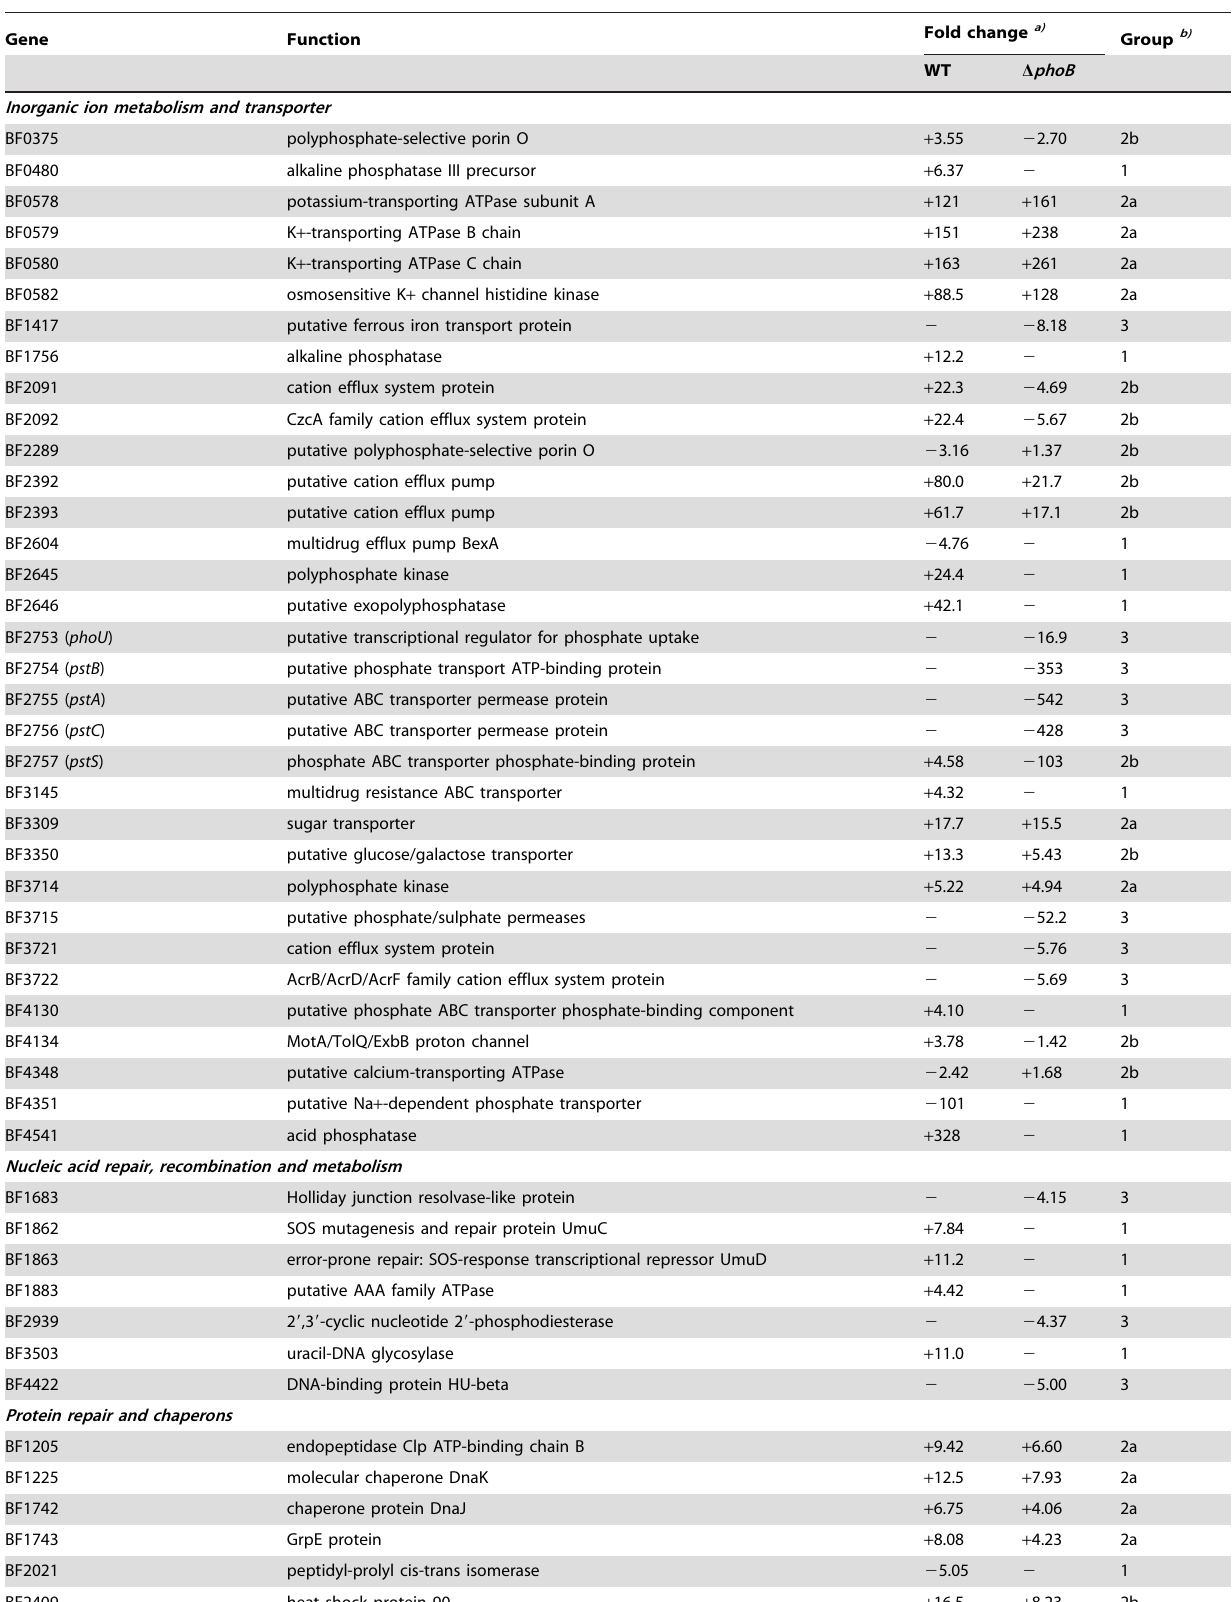
Table 2. Representative list of differentially expressed genes in wild type and D phoB B. fragilis strains in Pi-limiting conditions.